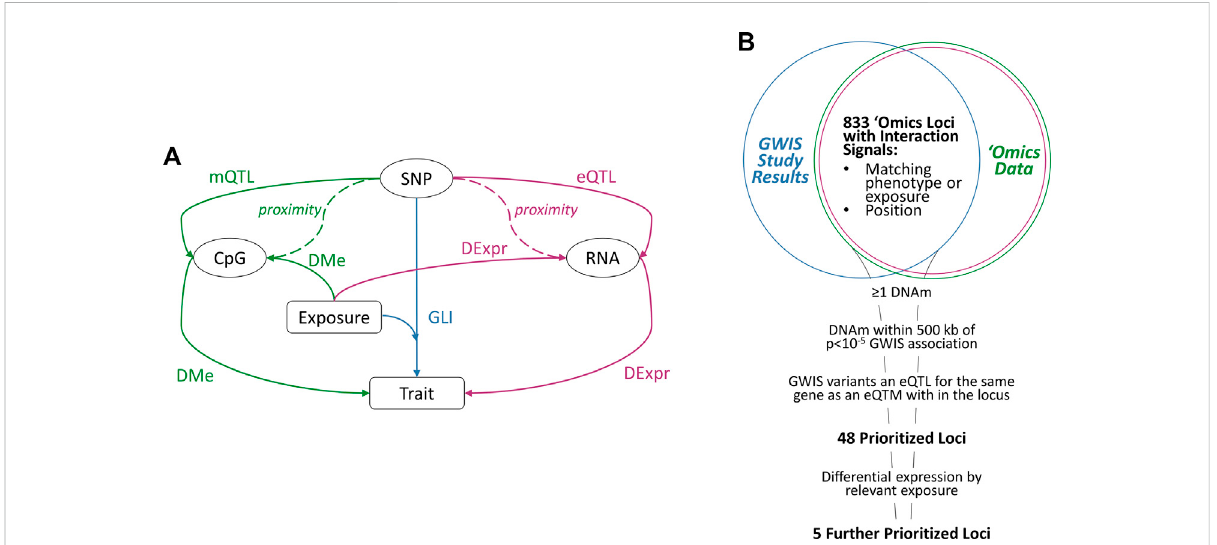
FIGURE 1 (A) Illustration of Possible Mechanisms Underlying Interaction Signals; rectangles represent study traits or measured lifestyle exposures; ovals represent three types of molecular risk factors: SNP genotype, RNA expression, and DNA methylation. Interactions are depicted by the “ SNP- Exposure-Trait ” path (GLI), with possible underlying molecular mechanisms shown along the sides for the transcriptomic (RNA expression) and epigenomic level (DNAm). The molecular effects are represented by solid arrows: expression QTL effect of a SNP allele on RNA expression levels (eQTL analysis) or methylation (mQTL analysis); differential methylation of a CpG site by trait or exposure (DMe analysis); and differential expression by trait or exposure (DExpr analysis). Dashed lines indicate physical proximity between elements. (B) Prioritization of GLI Loci; a panel of GLI loci from multiple genome-wide interaction studies (blue) were intersected with publicly-available epigenomic (green) and transcriptomic (purple) data for the relevant variants, lifestyle exposures, and traits. The resulting data were then prioritized using the listed criteria to yield 48 loci with multiple sources of molecular evidence underlying the interaction and fi ve loci with differential expression by the exposure of